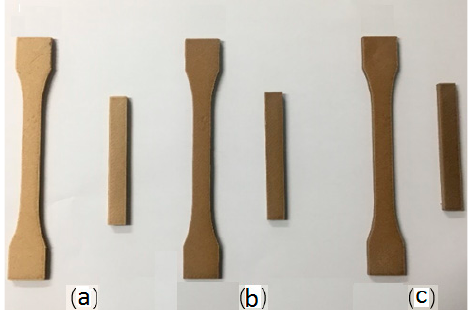
Figure 2. The printed samples using different natural fiber powder/PLA biocomposites: ( a ) ARP/PLA; ( b ) RSP/PLA; and ( c )